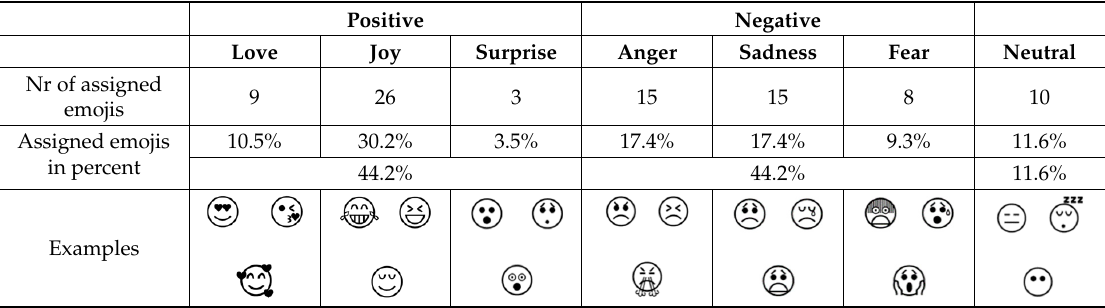
Table 1. Summary of the assignment of emojis to emotional categories.